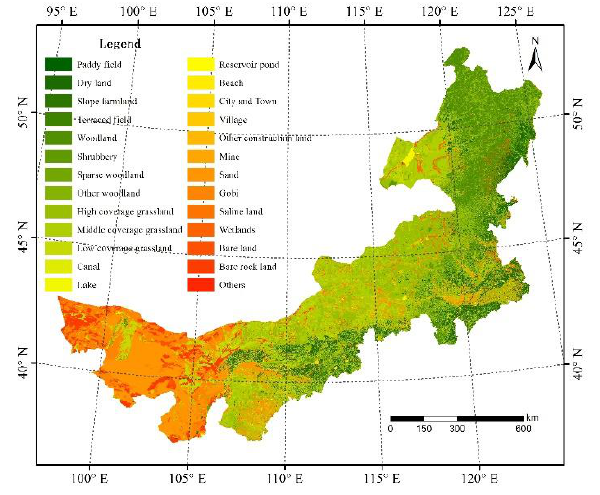
Figure 3.Land Use Map of Inner Mongolia Region in 2018 It was found that in 2018, the area of arable land in the Inner Mongolia was 115,600 km 2 (accounting for 10.05% of the total area of the Inner Mongolia Region, the same below), the forest area was 165,900 km 2 (14.42%), the grassland area was 525,200 km 2 (45.65%), and the water area was 1.42 10,000 km 2 (accounting for 1.24%), urban and rural, industrial, mining, and residential land area of 18,200 km 2 (accounting for 1.59%),